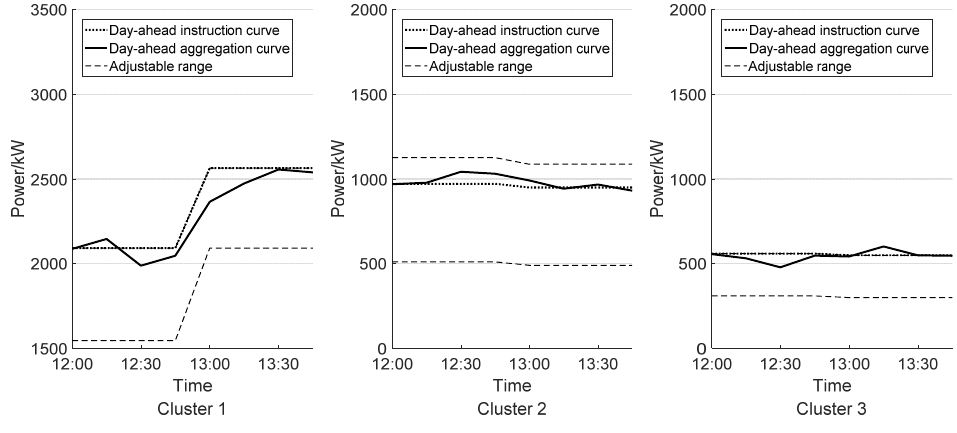
Figure 9. Grid ‐ to ‐ system instruction curve.